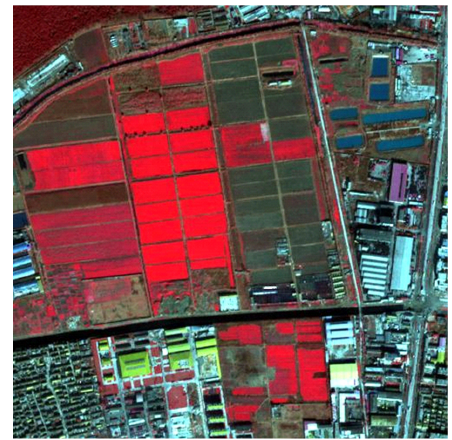
Figure 4. False color composite of QuickBird remote sensing